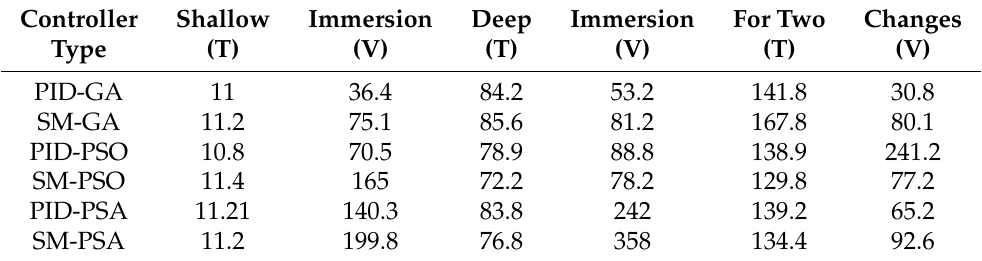
Table 3. Values of fitness function no. 2 for tuning (T) and verifying (V) BUV’s depth controllers for three changes of desired immersion: shallow, deep and two depths